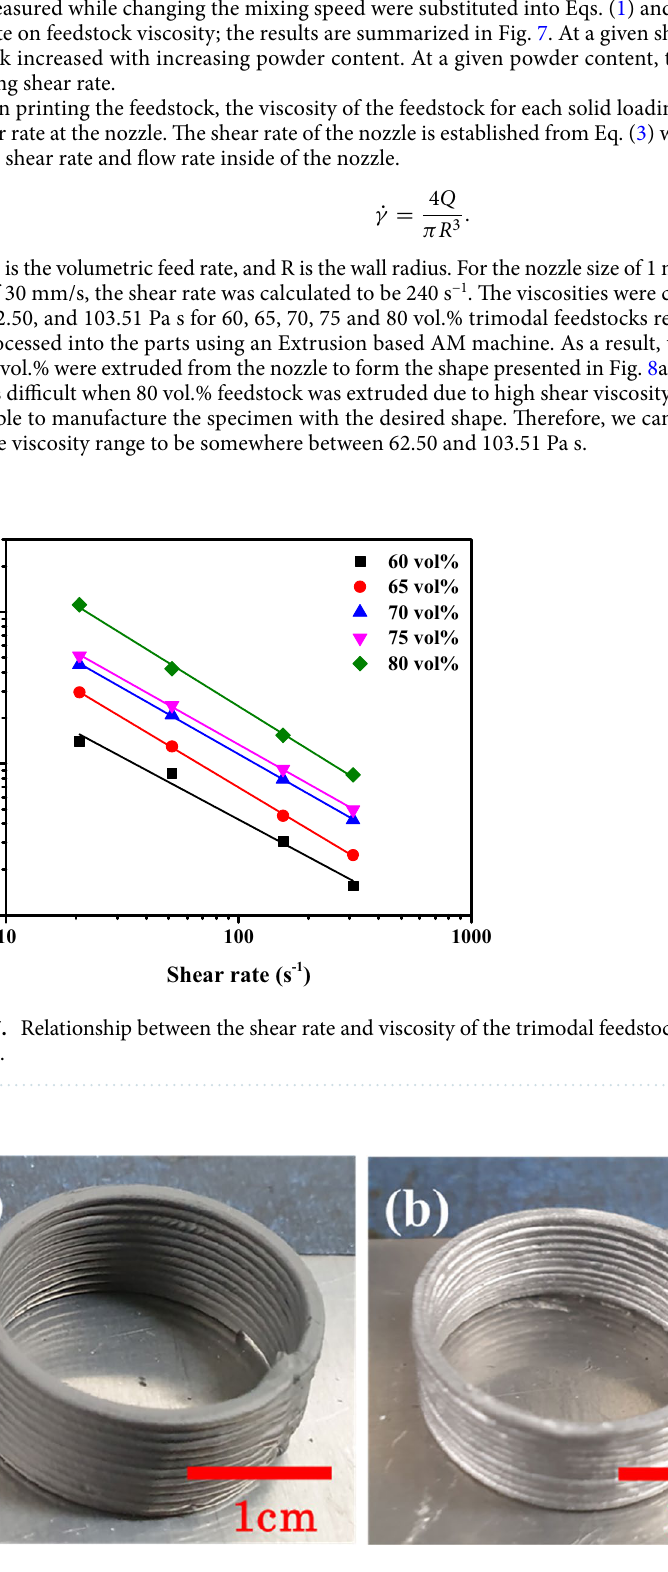
Figure 8. Photographs of the 70 vol.% part ( a ) additively manufactured and ( b )